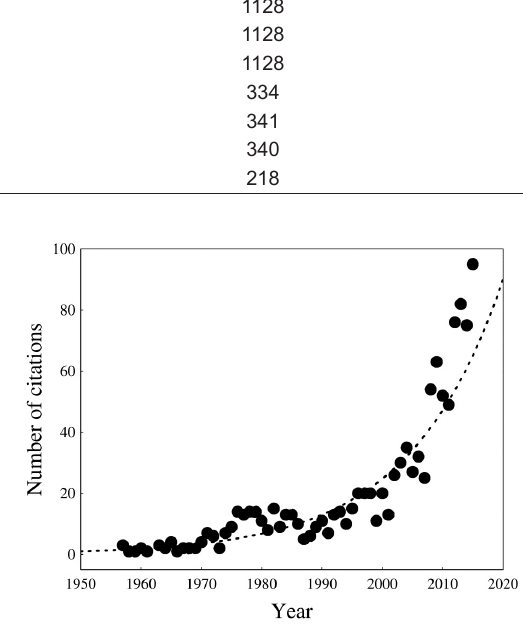
Figure 1. Temporal trend in the number of papers citing ‘Le Cren, 1951’ based on a search from 1951 to December